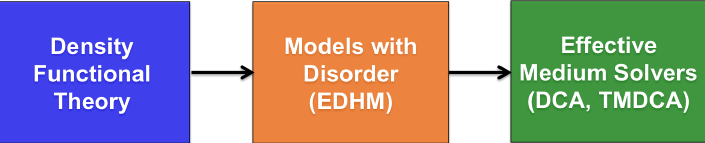
Figure 28. Organization of the modular approach to first-principles calculations of localization. A DFT of the pure system and a DFT supercell calculation of a single impurity are performed as the first step. In the second step, the EDHM converts the DFT output into model parameters of the disordered system. In the third step, the TMDCA is used to study the materials-specific localization